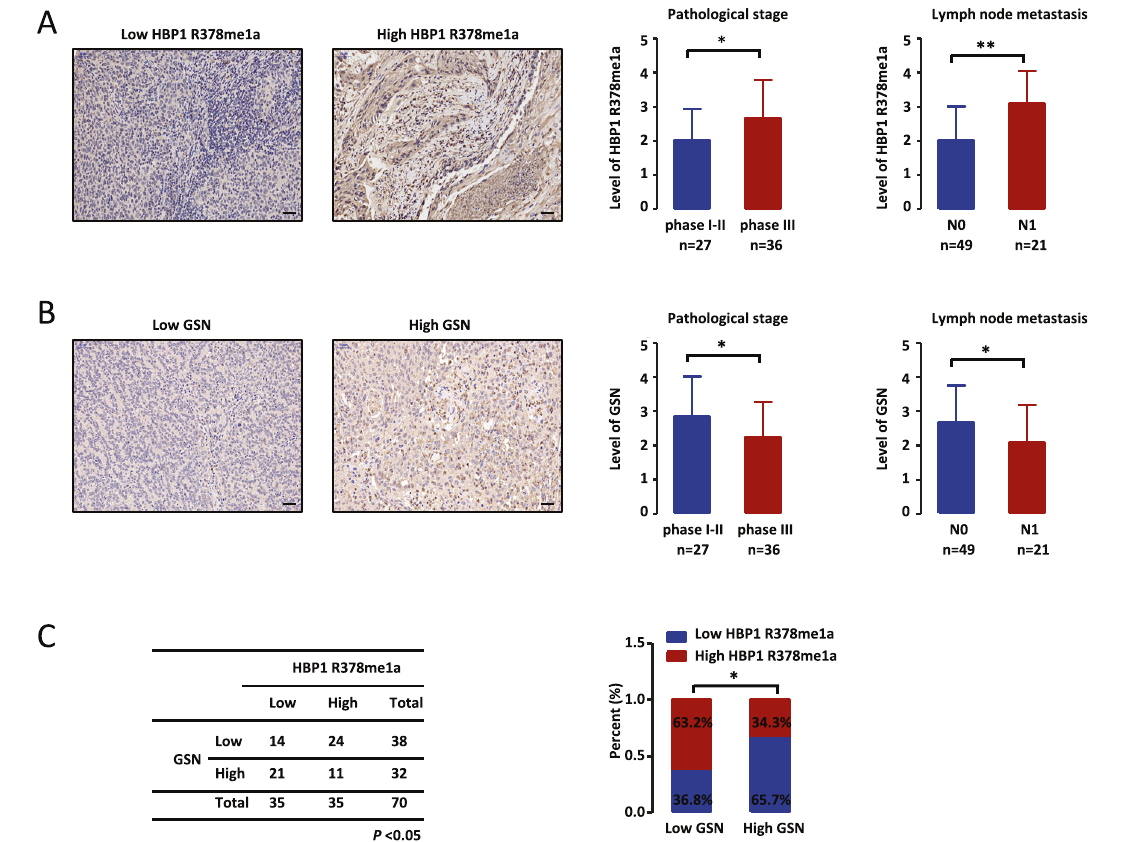
Fig. 7 Elevated expression of methylated HBP1 and reduced levels of GSN in cervical cancer samples are associated with poorer clinical outcomes. A – C High level of HBP1 methylation and low GSN expression relate to poor prognosis. A , B IHC assays were performed using anti- HBP1 R378me1a and anti-GSN in 70 cervical cancer tissue samples. Representative images were presented. Scale bar, 50 µm. ( n = 70, Student ’ s t -test) C Correlation between HBP1 R378me1a and GSN expression was examined by Pearson correlation coef fi cient